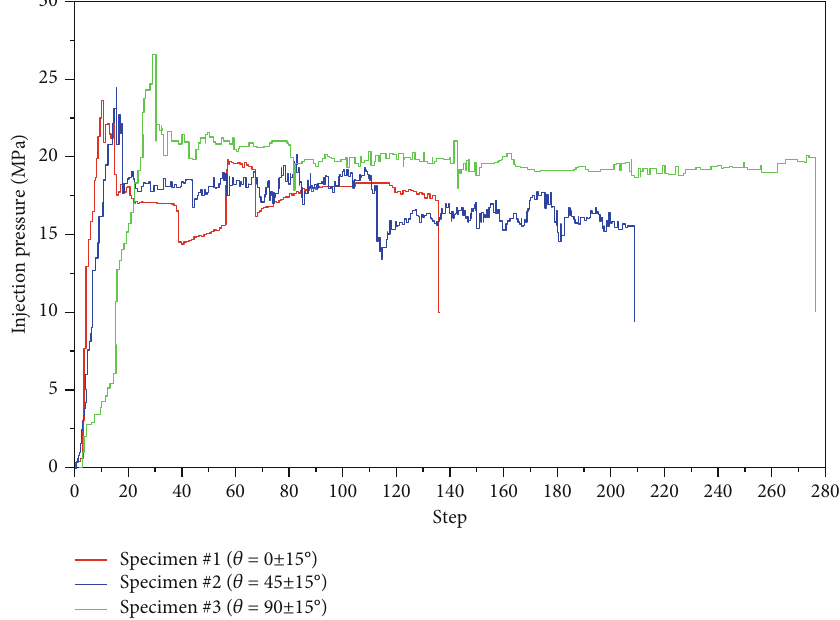
Figure 7: Injection pressure curves of di ff erent numerical